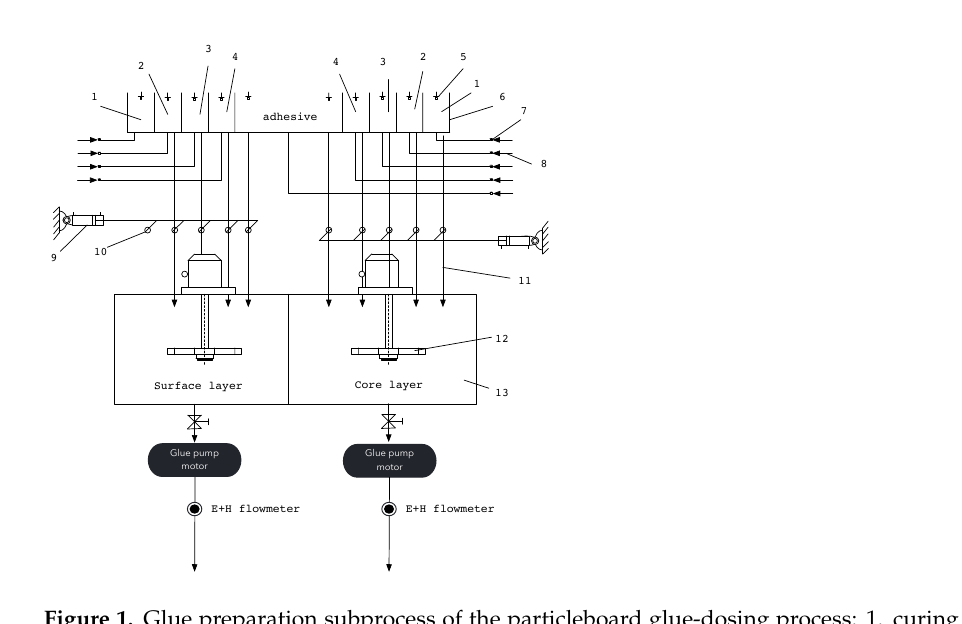
Figure 1. Glue preparation subprocess of the particleboard glue-dosing process: 1. curing agent; 2. waterproofing agent; 3. curing buffer agent; 4. water; 5. liquid level detector; 6. quantitative barrel; 7. electronically controlled throttle valve; 8. feeding tube; 9. cylinder; 10. ball valve; 11. blanking tube; 12. agitator; 13. glue mixing case.